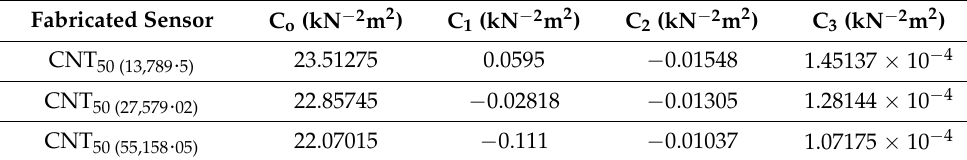
Table 1. Values of the intercept A and pressure factors C1, C2, and